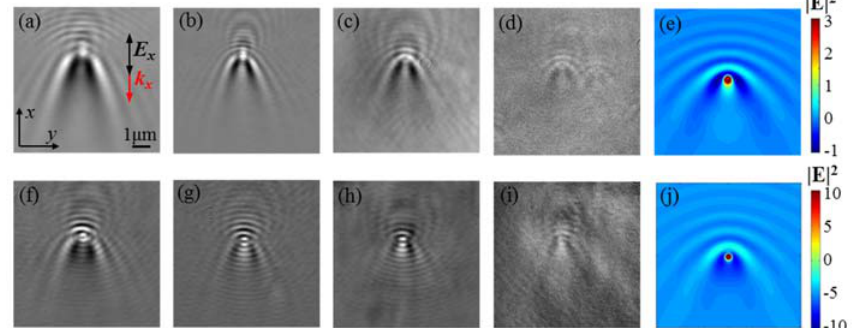
Figure 3. The TIR-based leakage radiation imaging of single polystyrene (PS) nanospheres under TM illumination with diameters of ( a ) 500, ( b ) 400, ( c ) 200, and ( d ) 100 nm. The imaging of single Au nanospheres under TM illumination with diameters of ( f ) 200, ( g ) 100, ( h ) 60, and ( i ) 30 nm. The simulated near-field electric field intensity of a single ( e ) 200 nm PS nanosphere and ( j ) 200 nm Au nanosphere. The k x indicates the propagation direction of the evanescent waves.